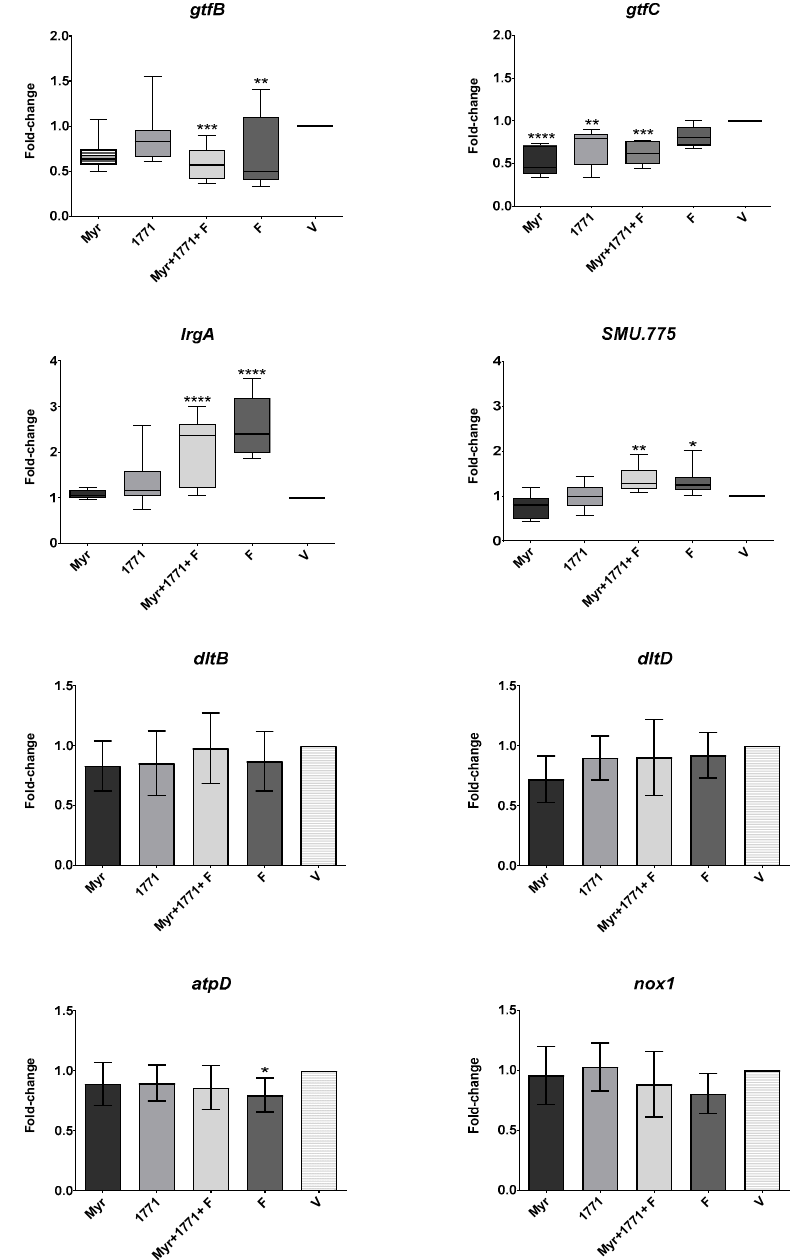
Figure 10. Gene expression profile of S. mutans biofilms after topical treatments. The fold-change is relative to vehicle-treated biofilms. Data presented are median and interquartile range are shown for genes gtfB , gtfC , IrgA , and SMU.775 (box plot graphs, Kruskal–Wallis test, followed by Dunn post-test), while mean and standard deviation for genes dltB , dltD , atpD , and nox1 (bar graphs; one-way ANOVA, followed by Tukey’s test). The asterisks depict significant statistical differences of treatments versus the vehicle, where * p ≤ 0.05, ** p ≤ 0.01, *** p ≤ 0.001, and **** p ≤ 0.0001. The data were obtained from three experiments (with two cDNA per experiment), and the quantification of qPCR expression was performed in duplicate.